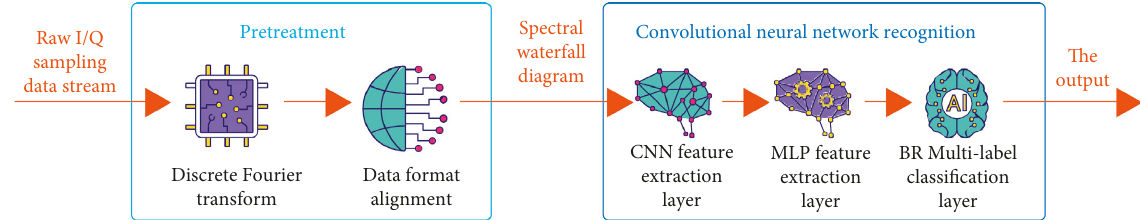
Figure 1: Electronic information signal recognition technology based on the stochastic neural network